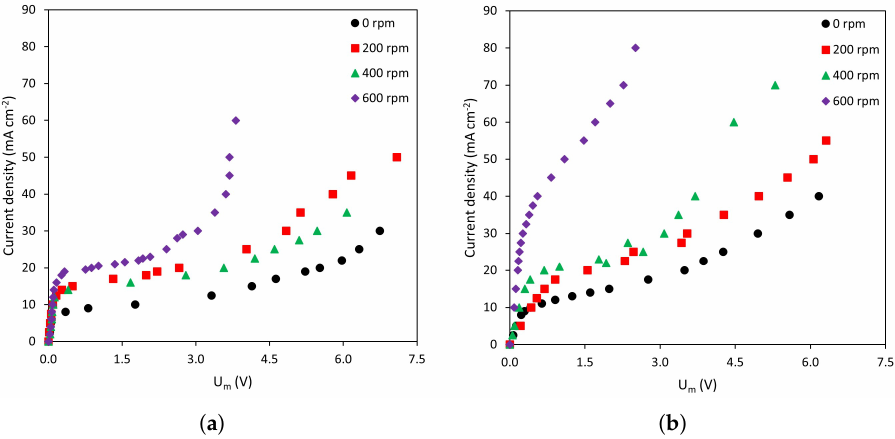
Figure 3. Current–voltage curves obtained at various stirring rates. ( a ) Homogeneous membrane, AMV-N; ( b ) Heterogeneous membrane,